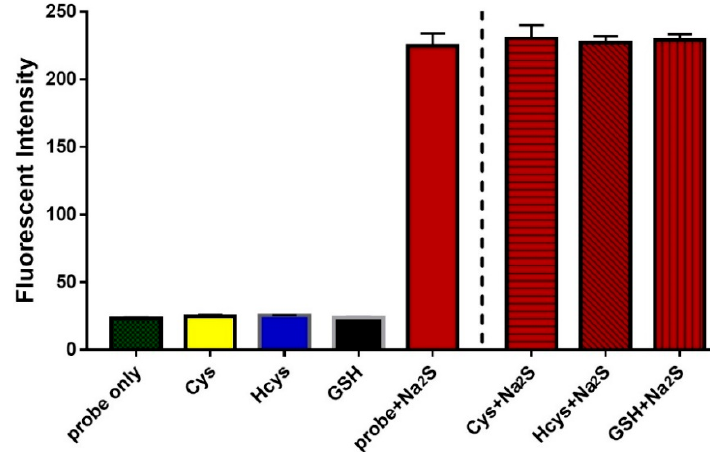
Figure 4. Fluorescence intensity at 660 nm of 1 (2 µM) upon reacting with biothiols (1 mM) or H 2 S (200 µM) or biothiols with coexistent H 2 S species in PBS buffer (pH 7.4) for 30 min.